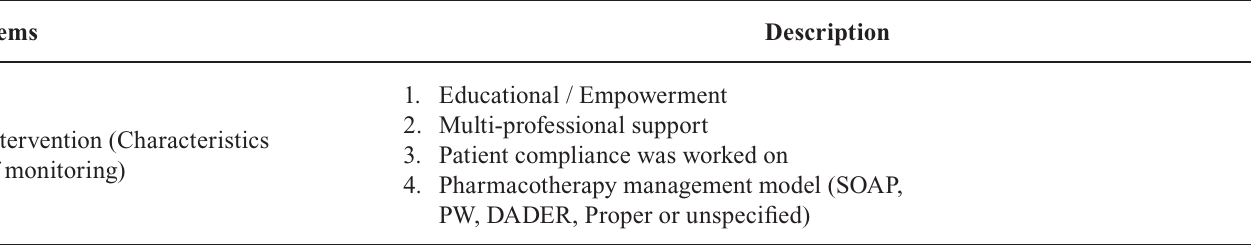
TABLE V - Checklist for Data extraction in this protocol and building the worksheet for databank